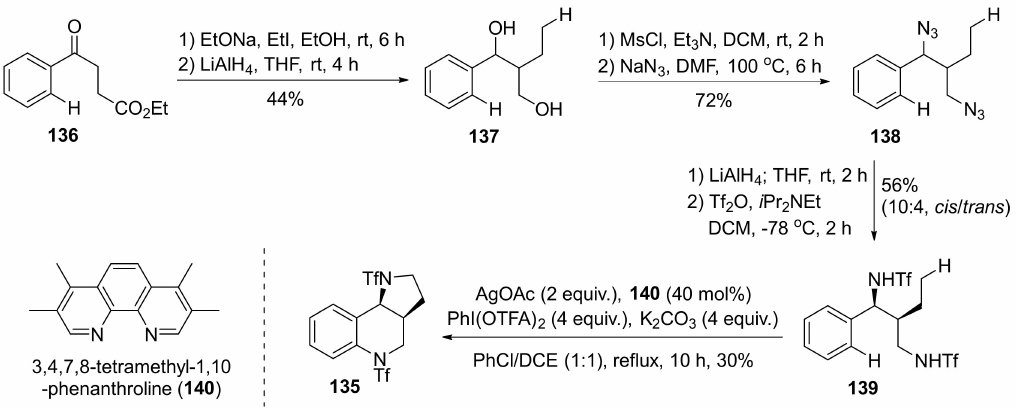
Scheme 22. Scaffold synthesis by Zhang and